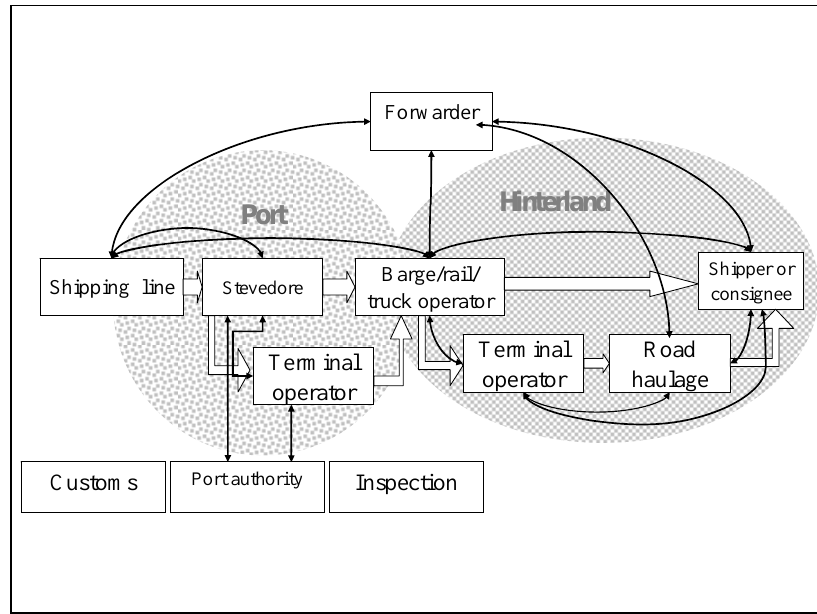
Figure 1. Organizational structure of port-hinterland transport chains Source: Van Der Horst and De Langen